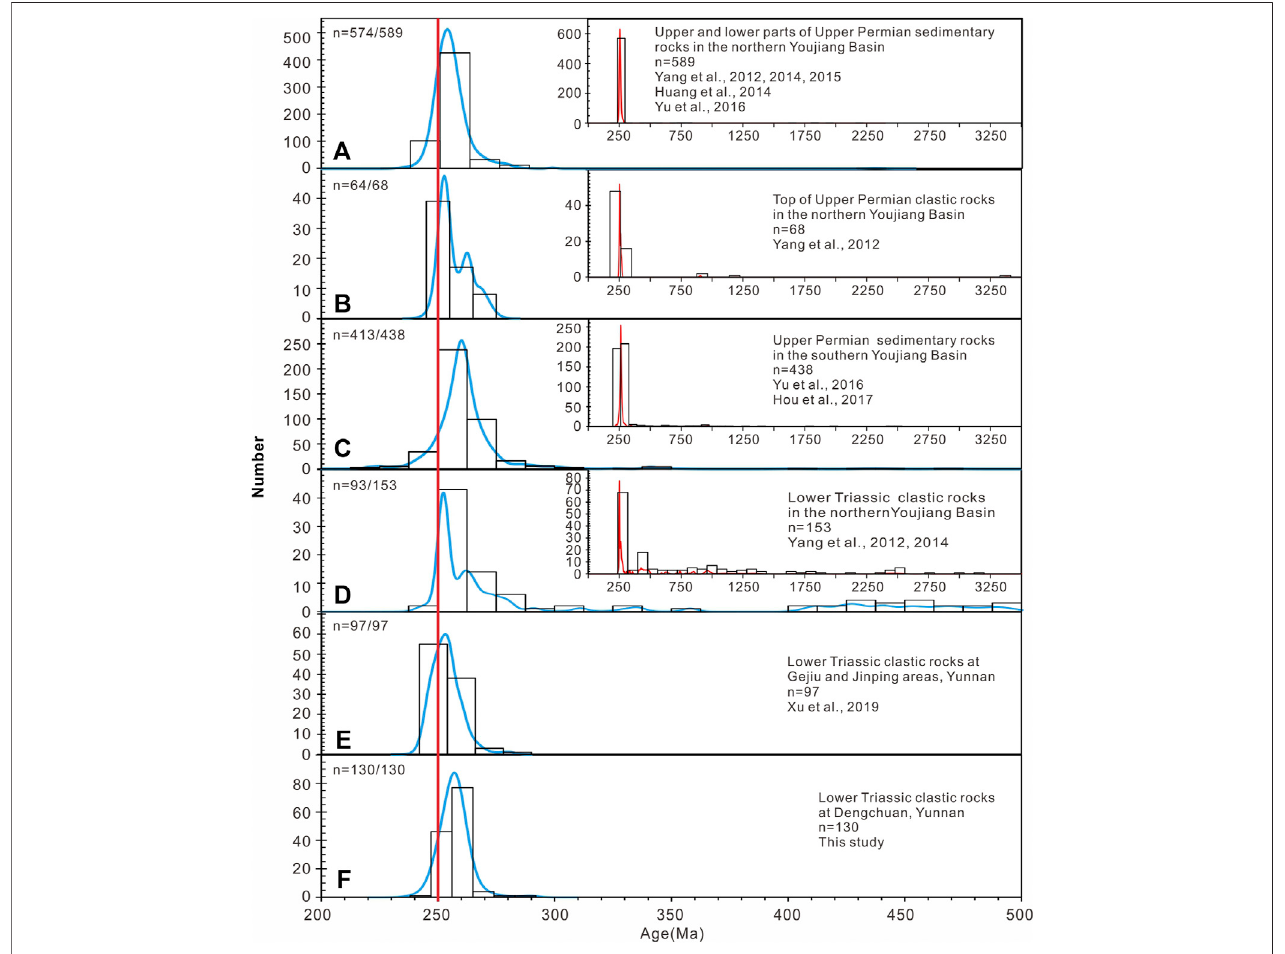
FIGURE 12 | (A – F) Probability density diagram comparing detrital zircon age patterns in the Upper Permian — Lower Triassic succession from the southwestern margin of the South China Craton.